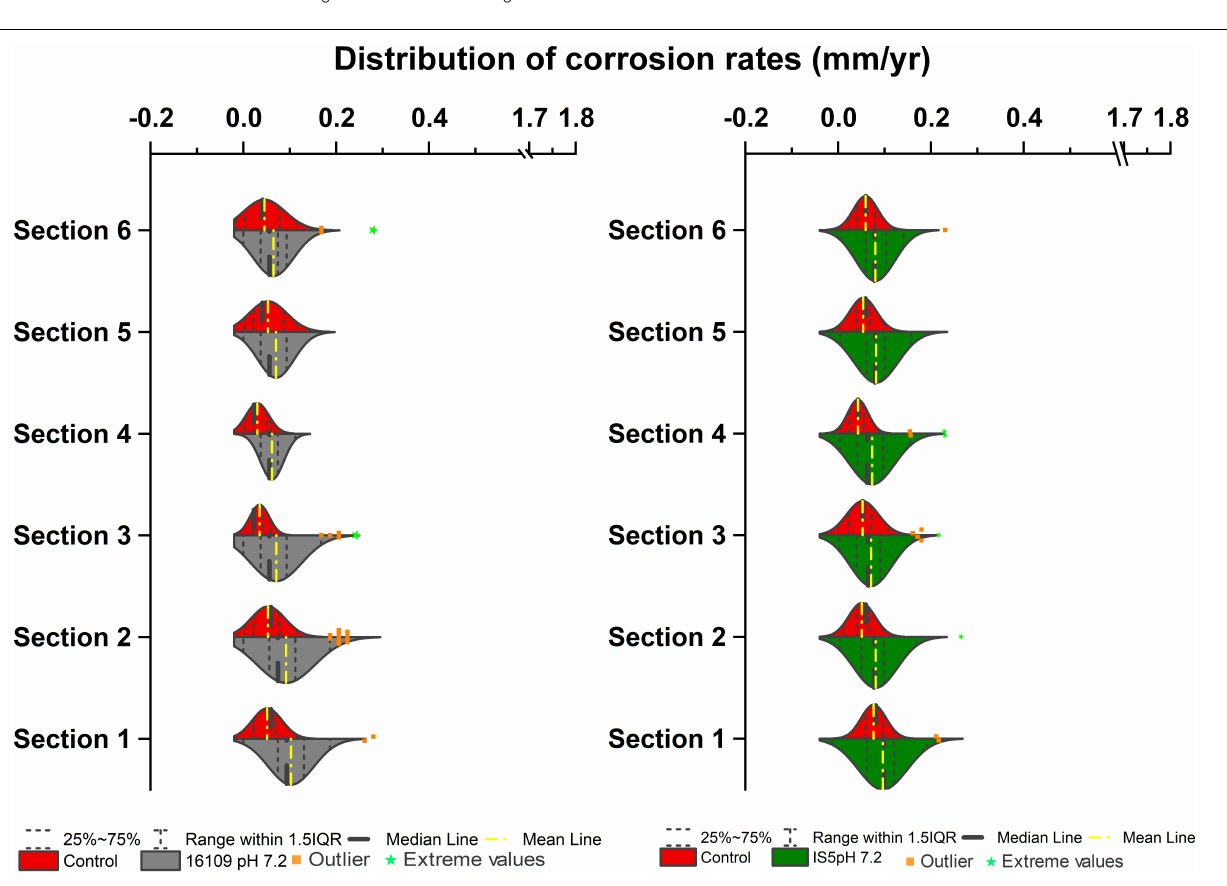
FIGURE 2 | Corrosion rates distribution (mm/yr) of D. alaskensis 16109 (left) and D. ferrophilus (right) at pH 7.2 compared against abiotic control in flow-through system columns incubated for 3.5 days without flow. Columns were filled with glass bead as separation medium and operated for 14 days with flow. Corrosion rate distribution, median and outliers of three biological replicates are